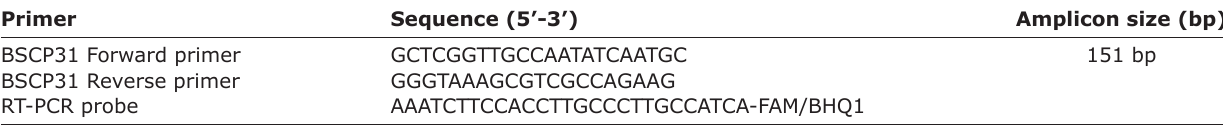
Table-1: RT-PCR oligonucleotides primers and probe of BCSF31 for Brucella species.